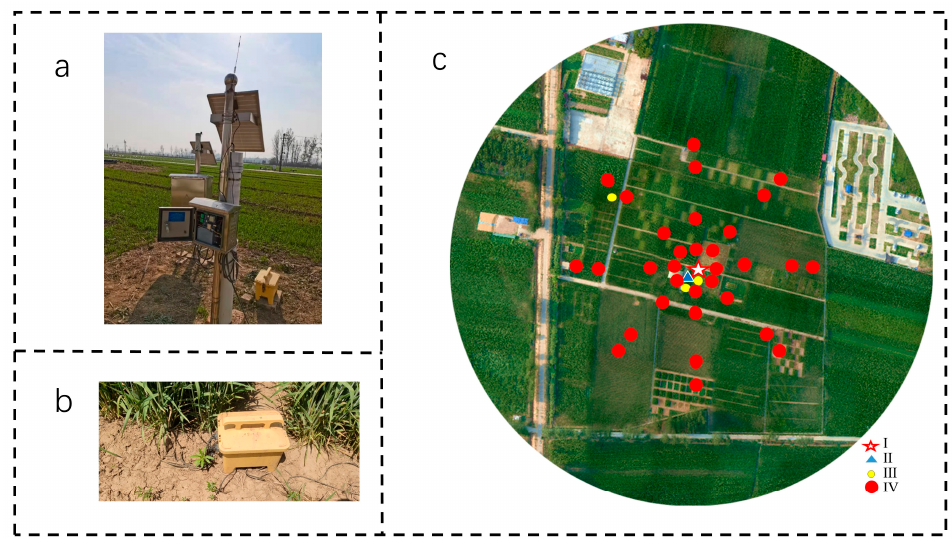
Figure 1. Location of the cosmic-ray neutron sensing probe and the experimental sampling design at Fengqiu station. ( a ) Cosmic-ray neutron sensing probe. ( b ) Frequency domain reflection (FDR) auto soil moisture monitor. ( c ) Bird’s-eye view of the study site, I: cosmic-ray neutron sensing probe; II: meteorological instrument; III: FDR auto soil moisture monitors; IV: soil sampling points.